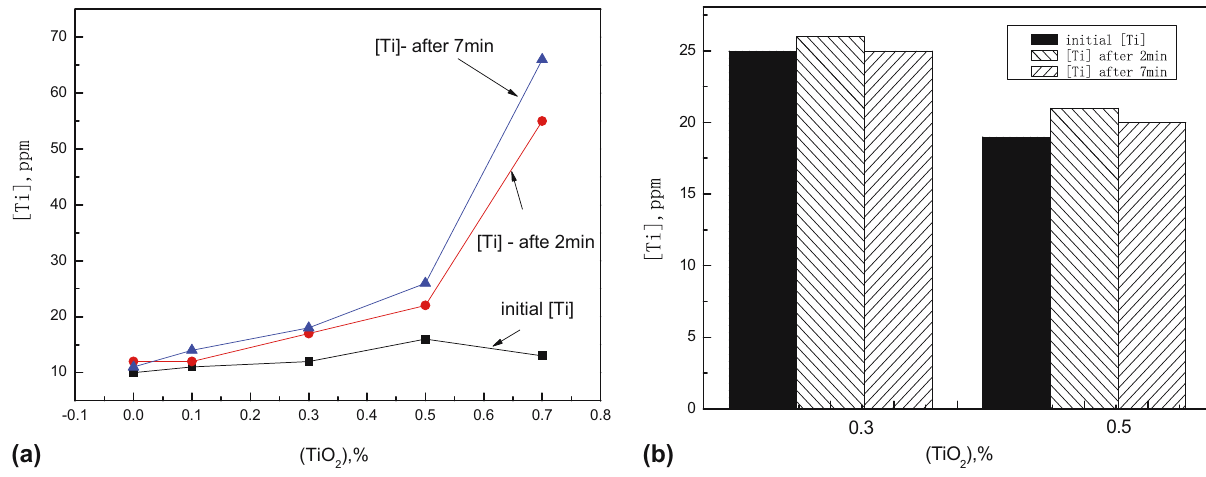
Figure 5: Variation in [ Ti ] content by adding di ff erent deoxidizer in re fi ning slag. ( a ) Al as di ff usion deoxidizer; ( b ) Si as di ff usion